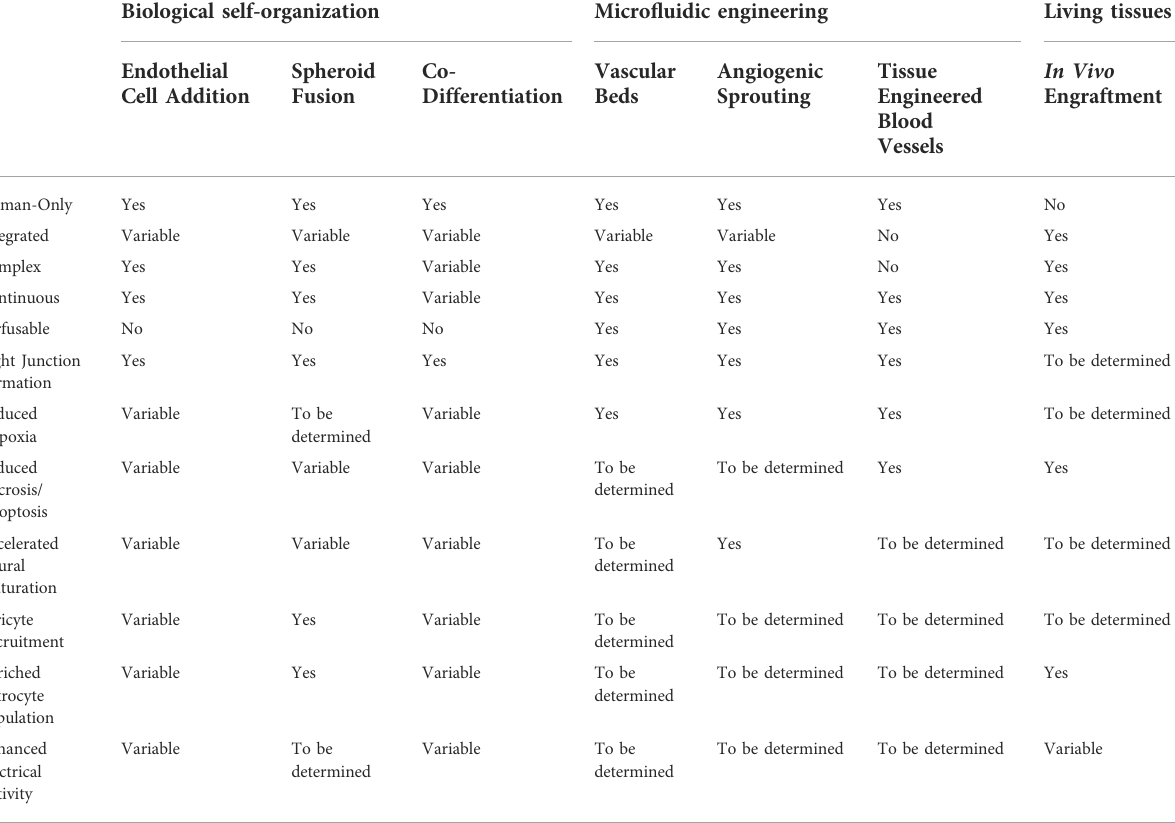
TABLE1Comparisonoforganoidvascularizationmethods.Tableoutliningthesuccessofeachorganoidvascularizationmethodatachievingrealistic vessel architecture, perfusability, and mature blood brain barrier